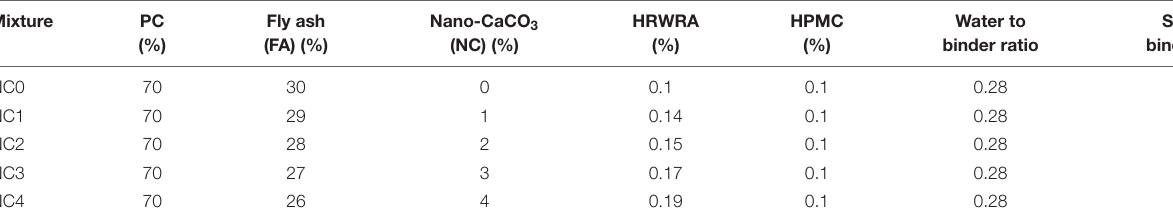
TABLE 2 | Mix proportion of specimens (by